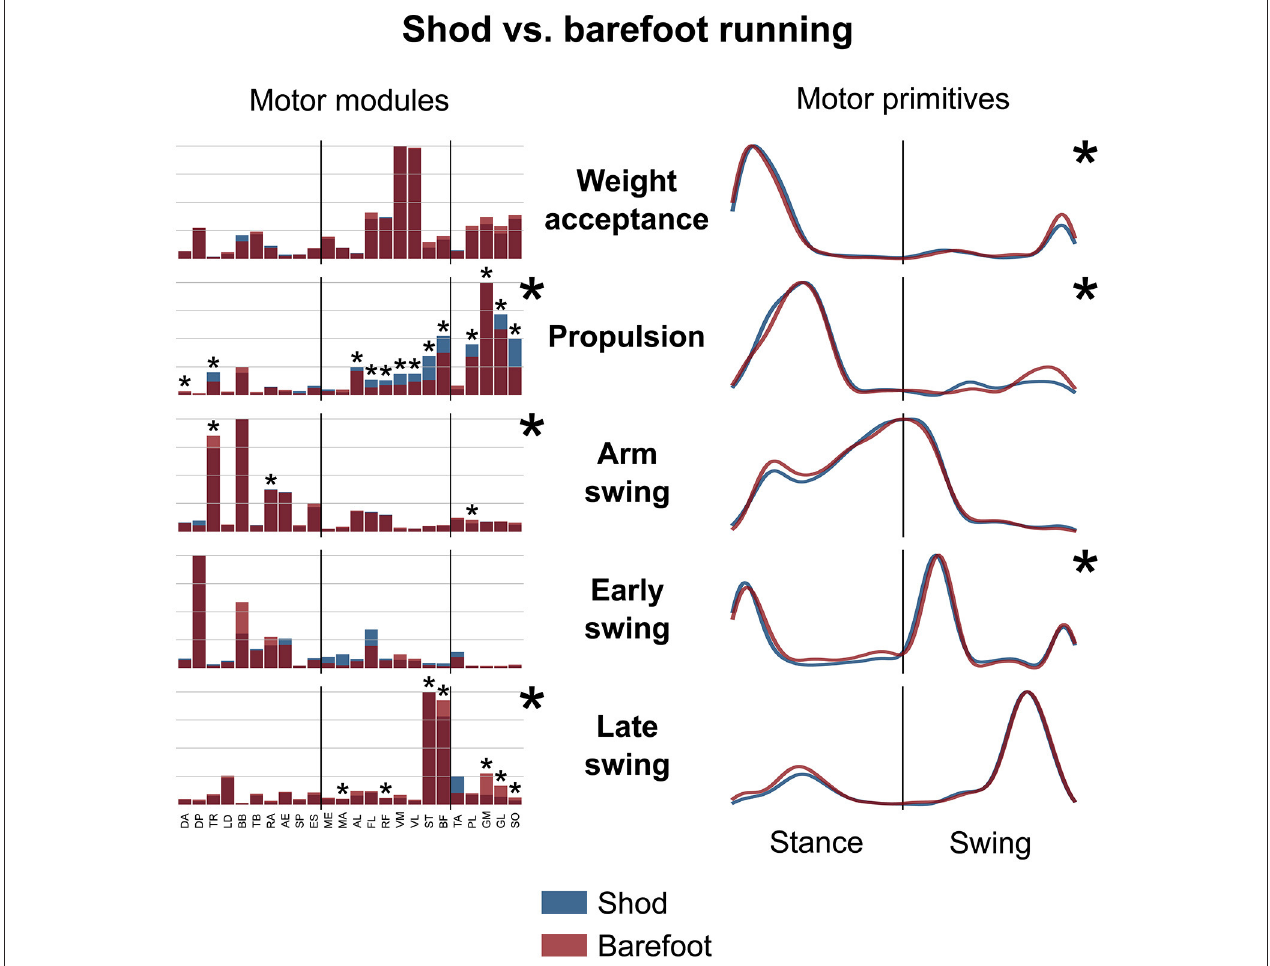
FIGURE 5 | Average motor modules and motor primitives of the five fundamental synergies for shod and barefoot running at the comfort speed. The motor modules are presented on a normalized y-axis base. For the motor primitives, the x-axis full scale represents one gait cycle (stance and swing normalized to the same amount of points and divided by a vertical line) and the y-axis the normalized amplitude. Asterisks denote significant differences between shod and barefoot